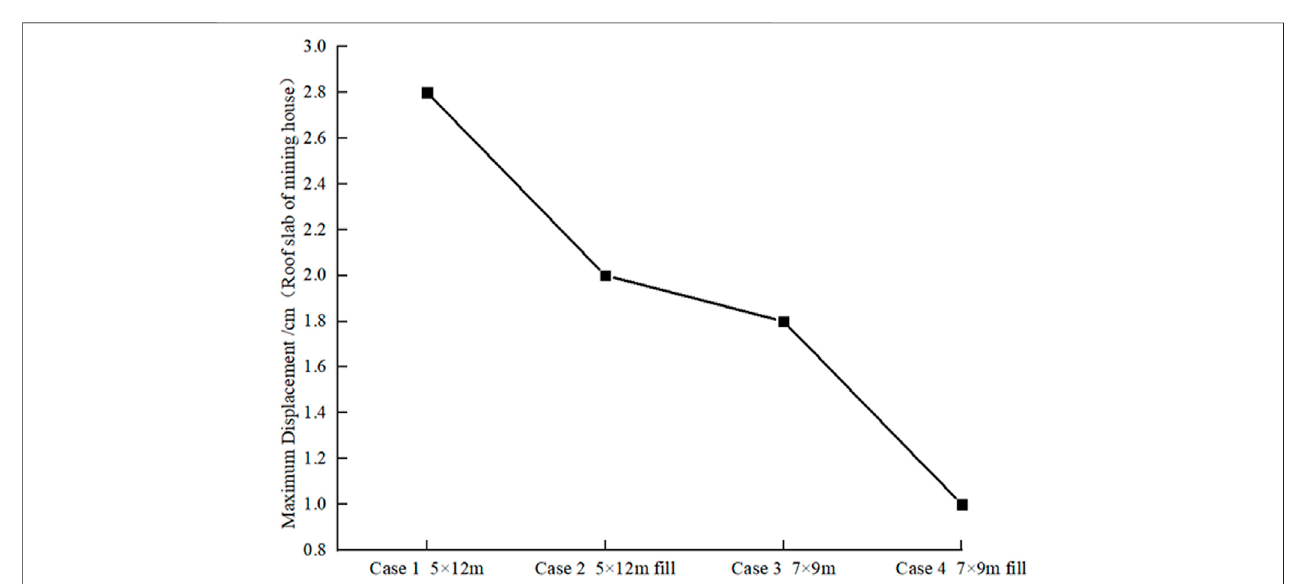
FIGURE 8 | Vertical displacement of stope roof in four